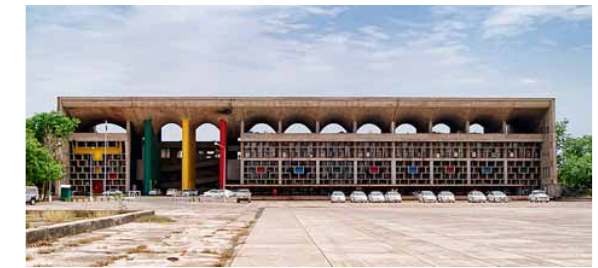
fig. 11. The Diwani am, fatehpur Sikri (from Petruccioli 2007) fig. 12. The High Court, Chandigarh (Scheidegger